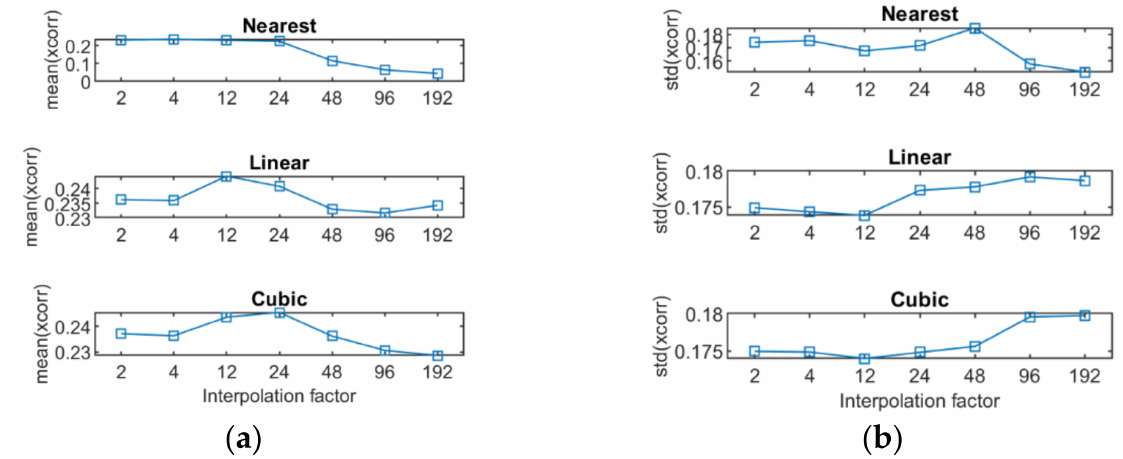
Figure 15. Mean xcorr ( a ) and xcorr standard deviation ( b ) describing the difference between the normalized temperature in R1 and the arc voltage.